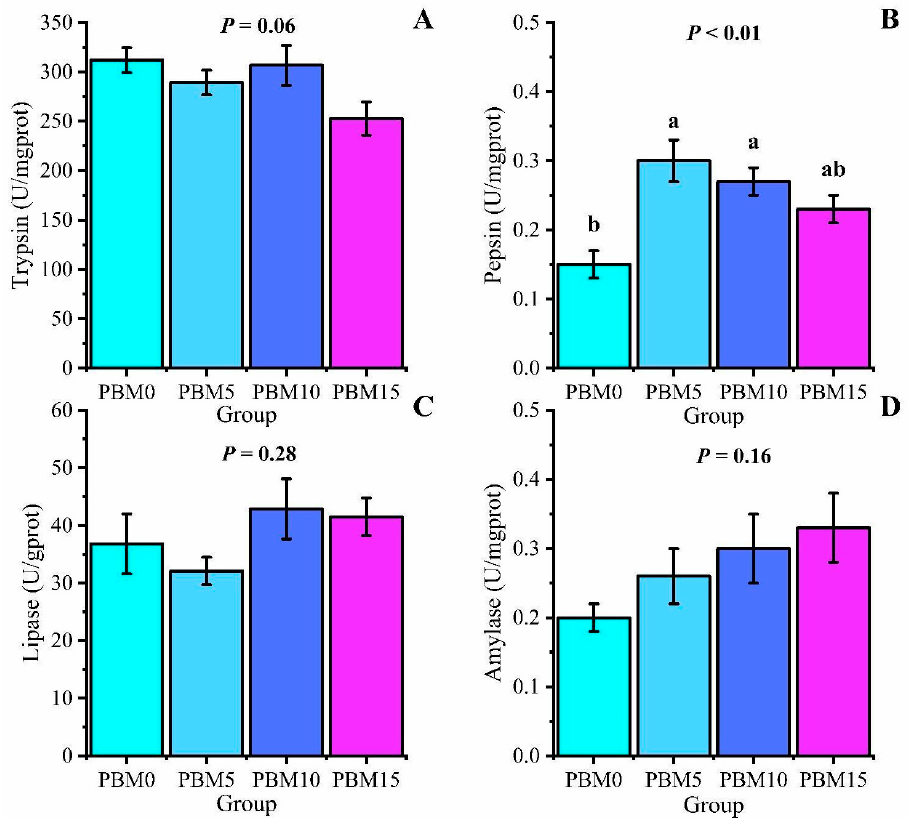
Figure 4. Effect of dietary replacement of fish meal with poultry by − product meal on the intestinal digestive enzyme activity of Chinese soft − shelled turtle. ( A ) Trypsin; ( B ) pepsin; ( C ) lipase; ( D ) amylase; Error bars was represented the mean ± standard error (n = 6). Different letters indicated significant differences between groups ( p < 0.05).